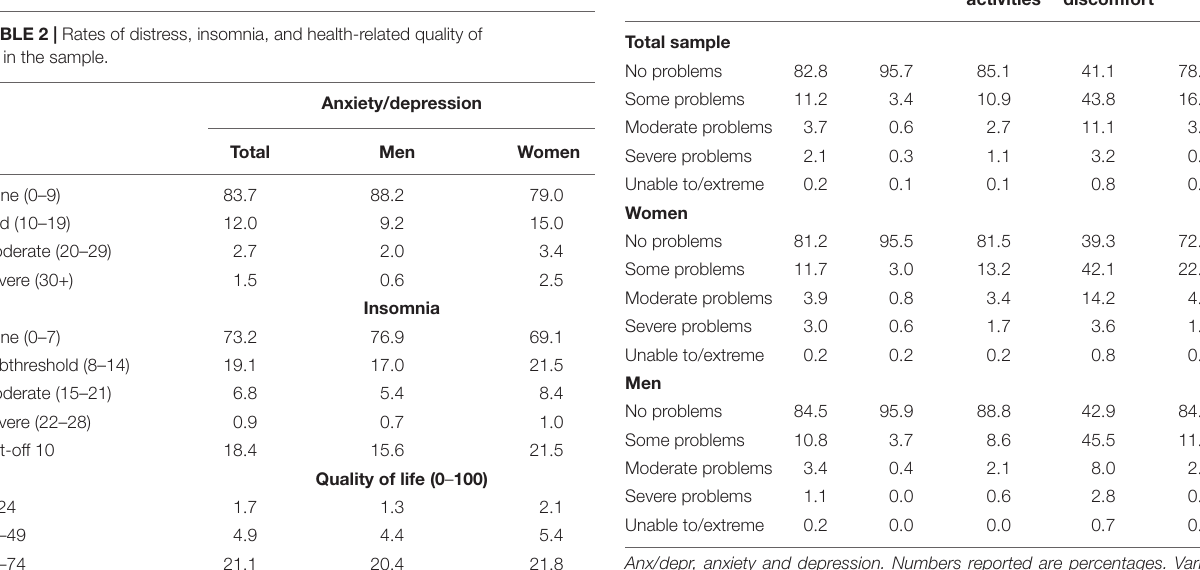
Anx/depr, anxiety and depression. Numbers reported are percentages. Variables scored as “unable to” = unable to walk (mobility), unable to wash/dress